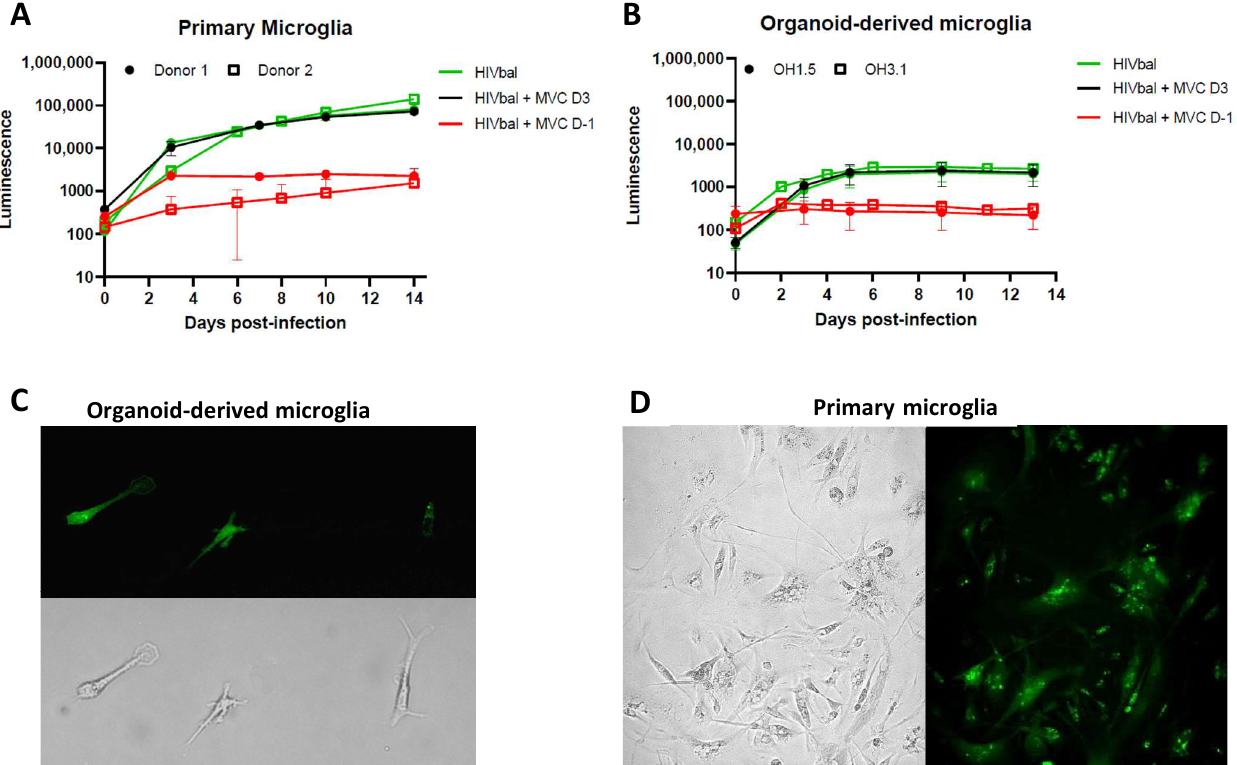
Figure 2. Primary microglia and organoid-derived microglia support productive HIV infection. ( A ) Organoid-derived microglia and ( B ) primary microglia were infected with HIVbal and treated with MVC (200 nM) pre-infection (D-1) and 3 days post-infection (D3). Supernatant was collected at each timepoint and analyzed for luciferase activity. The means ± standard errors of the means are shown. Representative pictures of ( C ) organoid-derived microglia (OH1.5) and ( D ) primary microglia infected with HIVbalGFP, taken in culture after 9 (oMG) and 11 days (pMG) of infection. All pictures were taken with a magnification of 20 ×